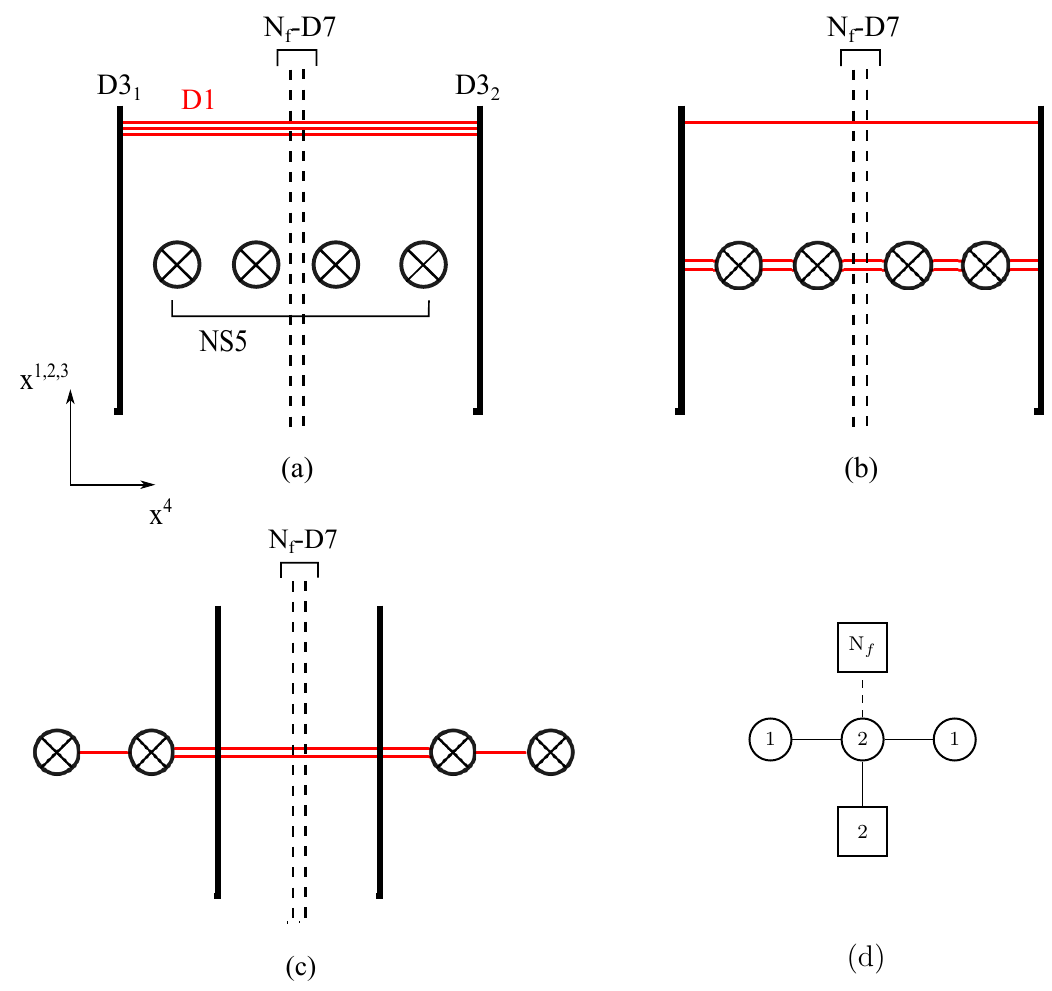
Figure 2 . This (cid:12)gure shows many facets of the brane con(cid:12)guration describing singular monopoles and monopole bubbling in 4D N = 2 gauge theory with N f fundamental hypermultiplets for the example of SU(2) gauge theory with (cid:13) m = 3 H 1 and P = 4 h 1 (a). (b) displays an example of monopole bubbling where 2 monopoles have bubbled, screening the defect. By performing the Hanany-Witten transformations (c), we can see that the SQM living on the D1-branes is given by a quiver SQM